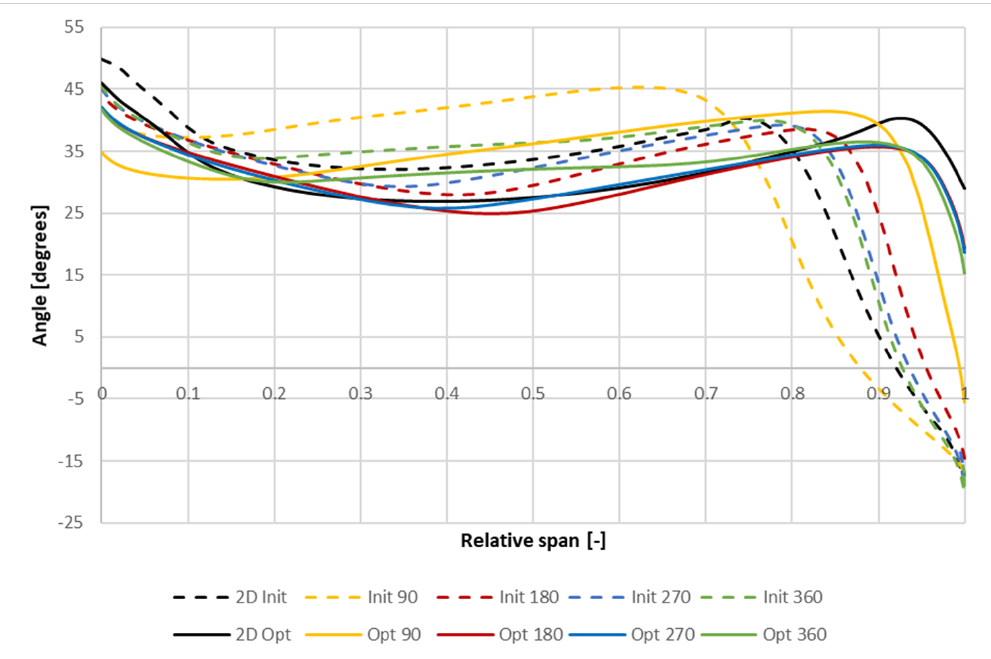
Figure 14. Spanwise distribution of the flow angle 𝛽 for different positions in initial (dashed line) and optimized (solid line) geometries.